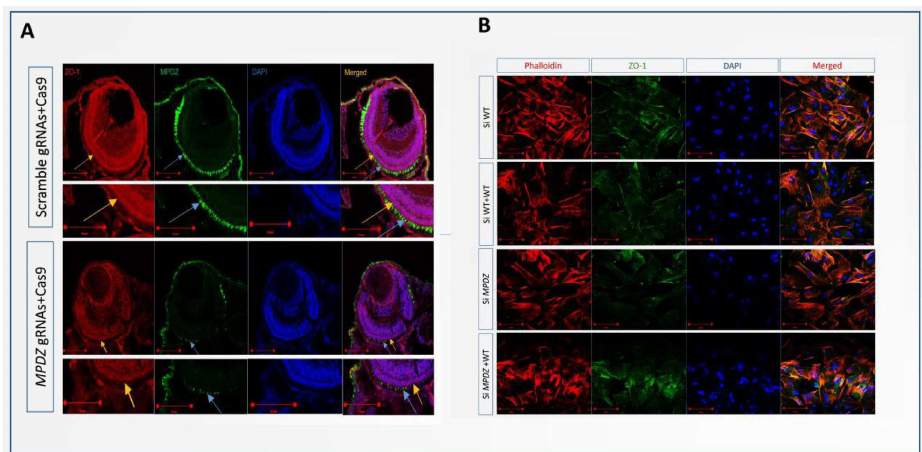
Figure 3. ( A ) IF staining showing that MPDZ localization in the ellipsoid zone of the MPDZ crispants retina, with intense green immunostaining (blue arrow), was decreased compared to the wildtype. ZO-1, mainly at the outer limiting membrane (OLM) (yellow arrow), was less expressed following the knockdown of MPDZ. ( B ) MPDZ knockdown with siRNA in cultured human RPE. IF staining showing the inhibition of MPDZ leading to cytoskeleton rearrangement and reduced ZO-1